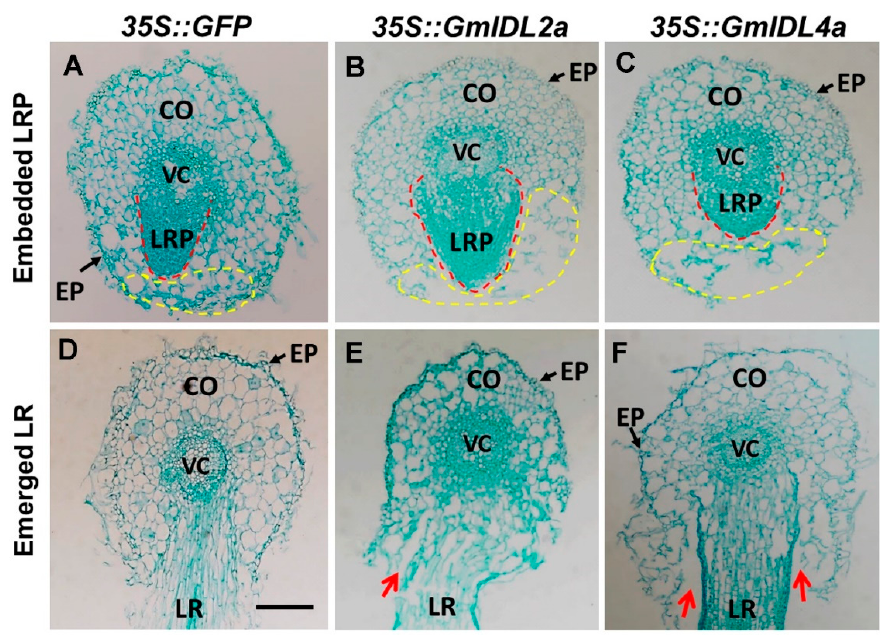
Figure 5. Histological sections of 35S::GFP , 35S::GmIDL2a , and 35S::GmIDL4a hairy roots. ( A – C ) Embedded LRPs of 35S::GFP ( A ), 35S::GmIDL2a ( B ), and 35S::GmIDL4a ( C ) hairy roots; ( D – F ) emerged LRs of 35S::GFP ( D ), 35S::GmIDL2a ( E ), and 35S::GmIDL4a ( F ) hairy roots. Yellow dashed lines indicate the overlaying tissues of embedded LRPs; Red dashed lines indicate the LRPs; Red arrows indicate the abnormal cell layer separation; EP, epidermal cells; CO, cortical cells; VC, vascular cylinder; LR, lateral root. Scale bar = 200 µ m.